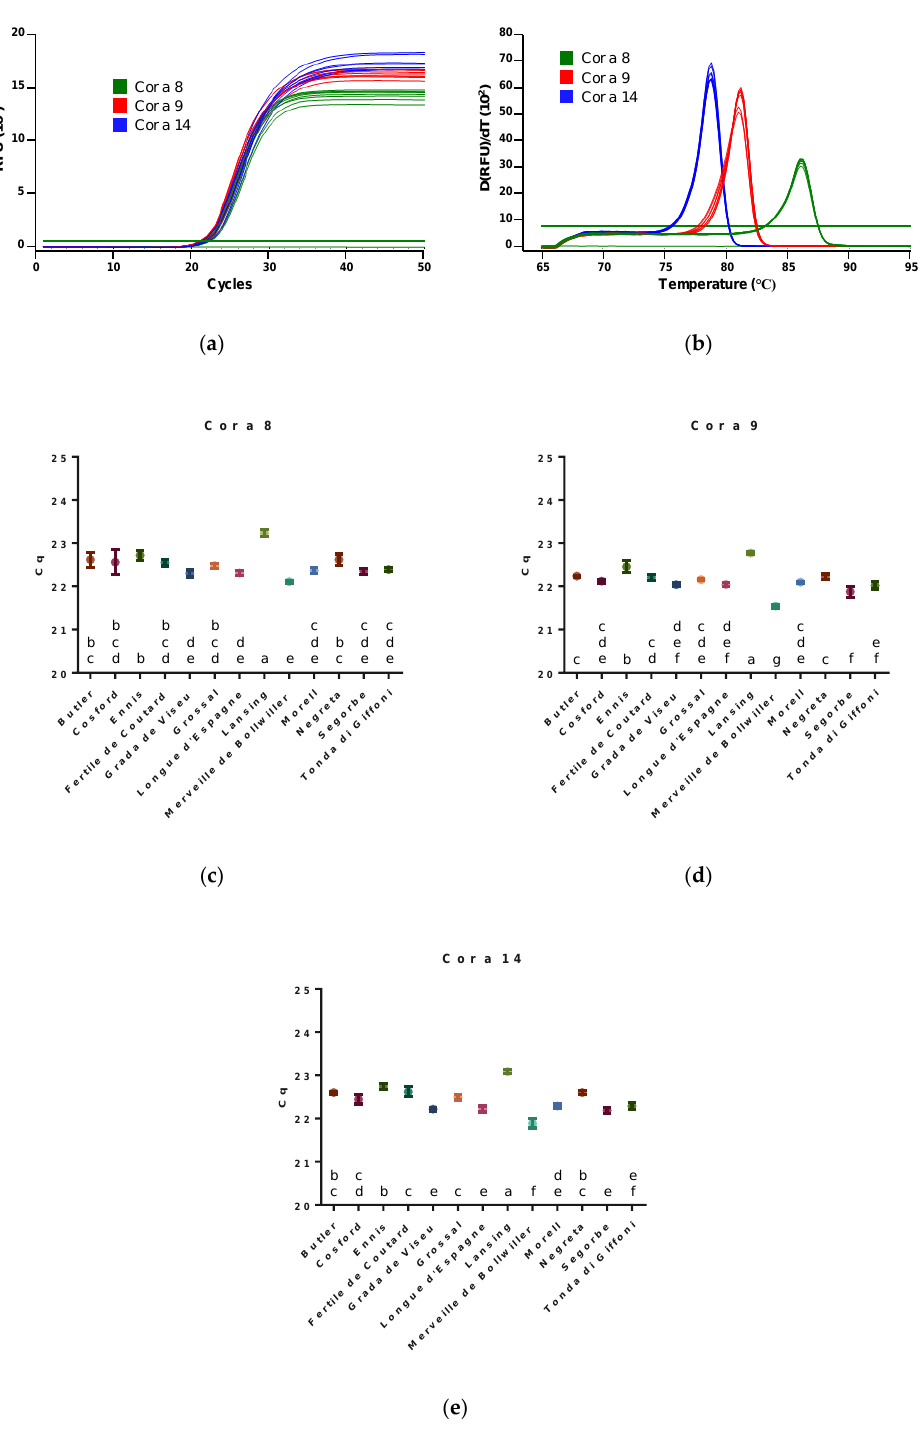
Figure 1. ( a ) Amplification curves and ( b ) melting peaks of different hazelnut varieties analyzed by real-time PCR using EvaGreen dye. Melting temperatures of 78.8 °C, 81.2 °C and 86.0 °C for PCR products from Cor a 14, Cor a 9 and Cor a 8, respectively. ( c ) Cor a 8, ( d ) Cor a 9 and ( e ) Cor a 14 cycles of quantification (Cq) values for the amplification of 20 ng of DNA from the di ff erent hazelnut varieties. Values with the same letter (a, b, c, d, e, f, g) do not di ff er significantly at p <